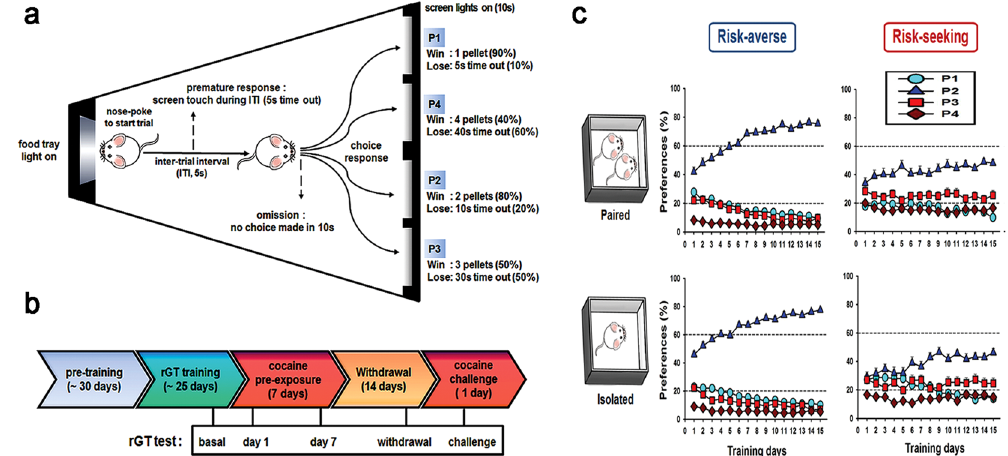
Figure 1. Rat gambling task apparatus, experimental schemes, and basal preference scores. ( a ) Schematic diagram of the rGT chamber, where a food magazine unit (left) and 4 response windows (right) are shown. Each window is represented as P1 through P4 with a different number of pellets, duration of time-out, and frequencies. ( b ) Time lines for the experimental procedures when the rGT tests were conducted are indicated. ( c ) Data obtained during the 15 consecutive days of stage 6 rGT training clearly show different preferences of choice between the groups. The risk-averse group overwhelmingly and consistently chose P2 over the other windows more than 60% of the choices after 6 days, whereas the risk-seeking group chose P2 less than 60% of the choices throughout the training days. The choice of P3 in the risk-averse group never increased more than 20% after 5 days of training, whereas it was always higher than 20% in the risk-seeking group throughout all the training days. There were no significant differences between the paired and isolated groups. However, there were small differences such as the choice of P3 decreased less than 20% faster in the isolated group than in the paired group (risk-averse), the choice of P1 decreased less than 20% later, and the choice of P2 was relatively a little lower in the isolated group than in the paired group (risk-seeking). The numbers of rats in each group were as follows: averse-paired (16), averse-isolated (20), seeking-paired (14), and seeking-isolated